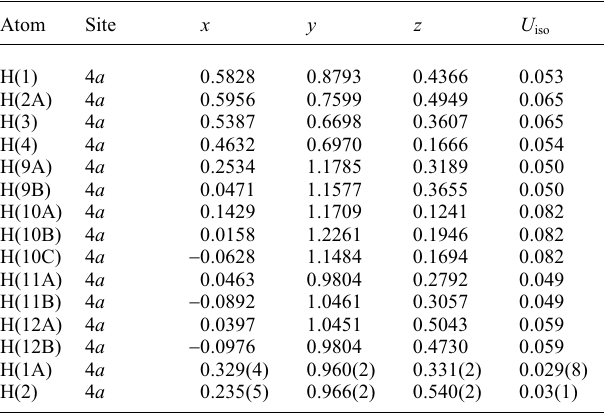
Table 2. Atomic coordinates and displacement parameters (in Å 2 )